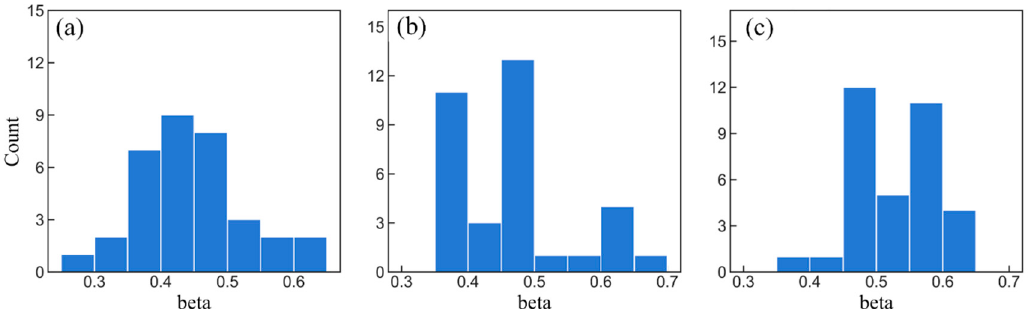
Figure 5. Empirical distributions (sampled values) for the β parameter at ( a ) the Hanjiang River catchment, ( b ) the Xiangjiang River catchment, and ( c ) the Ganjiang River catchment.